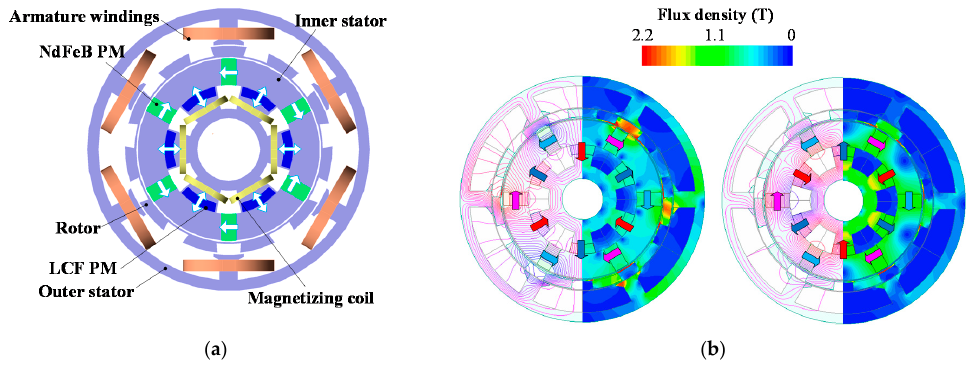
Figure 1. Proposed partitioned stator switched flux hybrid magnet memory machine (PS-SF-HMMM). ( a ) Configuration; ( b ) Operating principle.